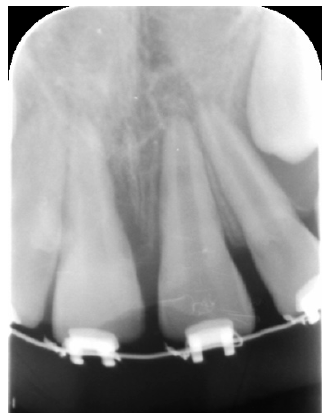
Figure 1. Periapical radiograph showing external root resorption involving external root walls of tooth 11 and periapical radiolucency involving tooth 21.